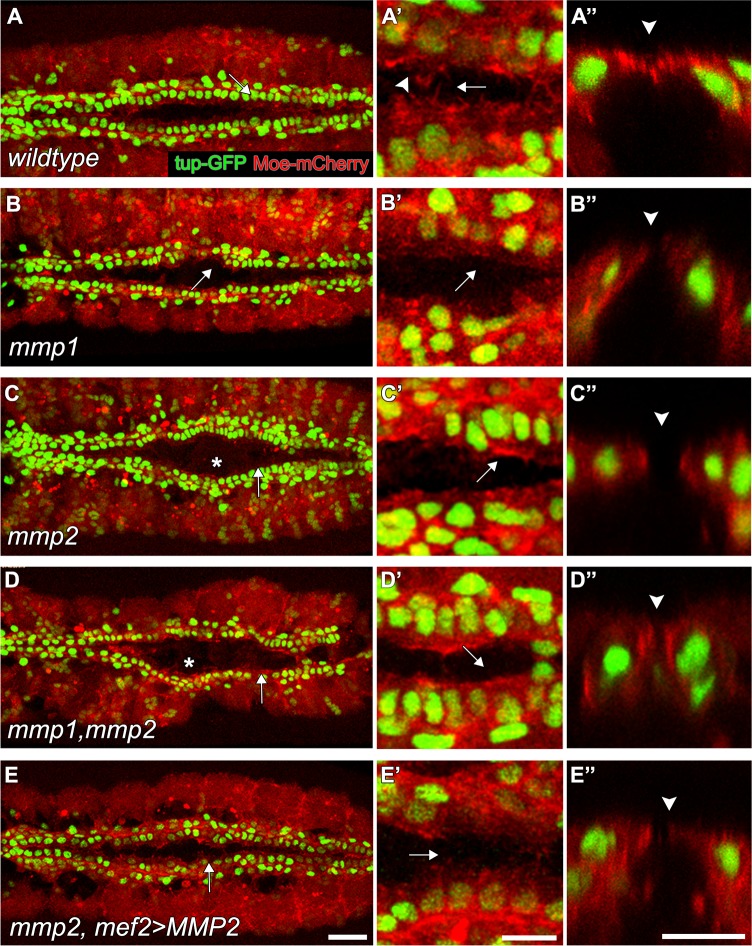
MMPs are required for the formation of filopodia and lamellopodia at the leading edge.Live embryos expressing tup-GFP (to visualise CB nuclei) and UAS-Moesin-mCherry under the control of mef2-GAL4 driver are visualised. Thin cytoplasmic protrusions were identified as filopodia, whereas sheet-like extensions were categorised as lamellopodia. (A-A”) In wildtype embryos, CBs extend finger-like filopodia (arrow) and sheet-like lamellopodia (arrowhead) towards their contralateral partner cells. CBs make contact at the dorsal midline (arrowhead). (B-B”) In mmp1 mutants, filopodial and lamellopodial activity at the leading edge is reduced (arrow) and CBs form short outgrowths towards their contralateral partners (arrowhead). (C-D”) In mmp2 and mmp1,mmp2 mutants delayed migration is observed (asterisk). CBs extend reduced numbers of filopodia and lamellopodia (C’,D’ arrow). CBs appear rounded without apical extensions towards the midline (C”,D” arrowheads). (E-E”) Expression of a mmp2 transgene in the CBs of mmp2 mutants restores formation of filopodia, lamellopodia (arrows) and apical outgrowths (arrowhead). Scale—25 μm in A-E and 10 μm in A’-E”.